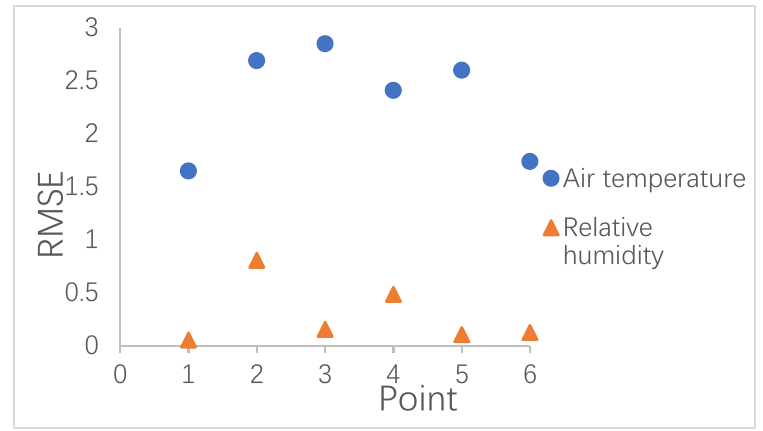
Figure 9. The root mean square error (RMSE) between measured and simulated data.